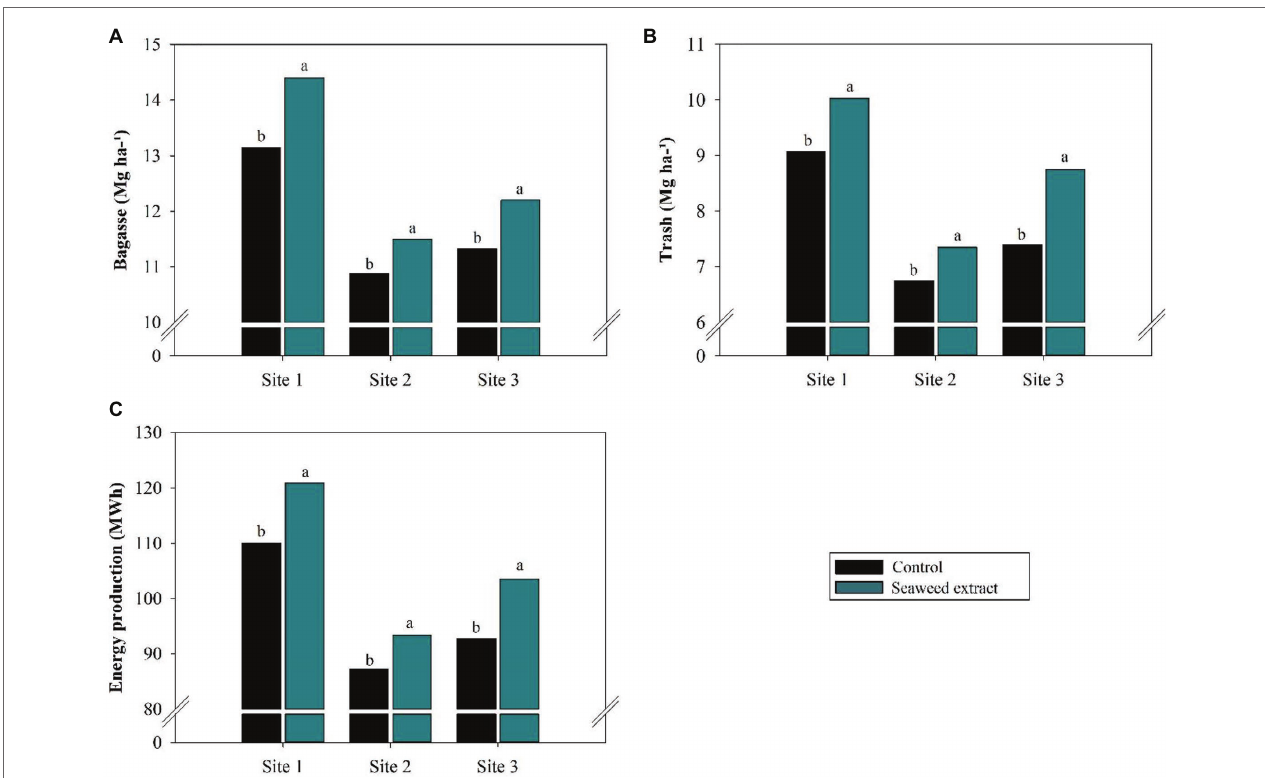
FIGURE 9 | Effects of seaweed extract (SWE) application on sugarcane biomass and energy parameters at harvest: (A) bagasse (Mg ha − 1 ); (B) trash (Mg ha − 1 ) and (C) energy production (MWh). The treatments were as follows: Control, no SWE application; Seaweed extract: application of SWE biostimulant based on Ascophyllum nodosum in the beginning of the drought season (July at site 1 and June at sites 2 and 3). Averages followed by the same letters do not differ by the LSD test ( p <